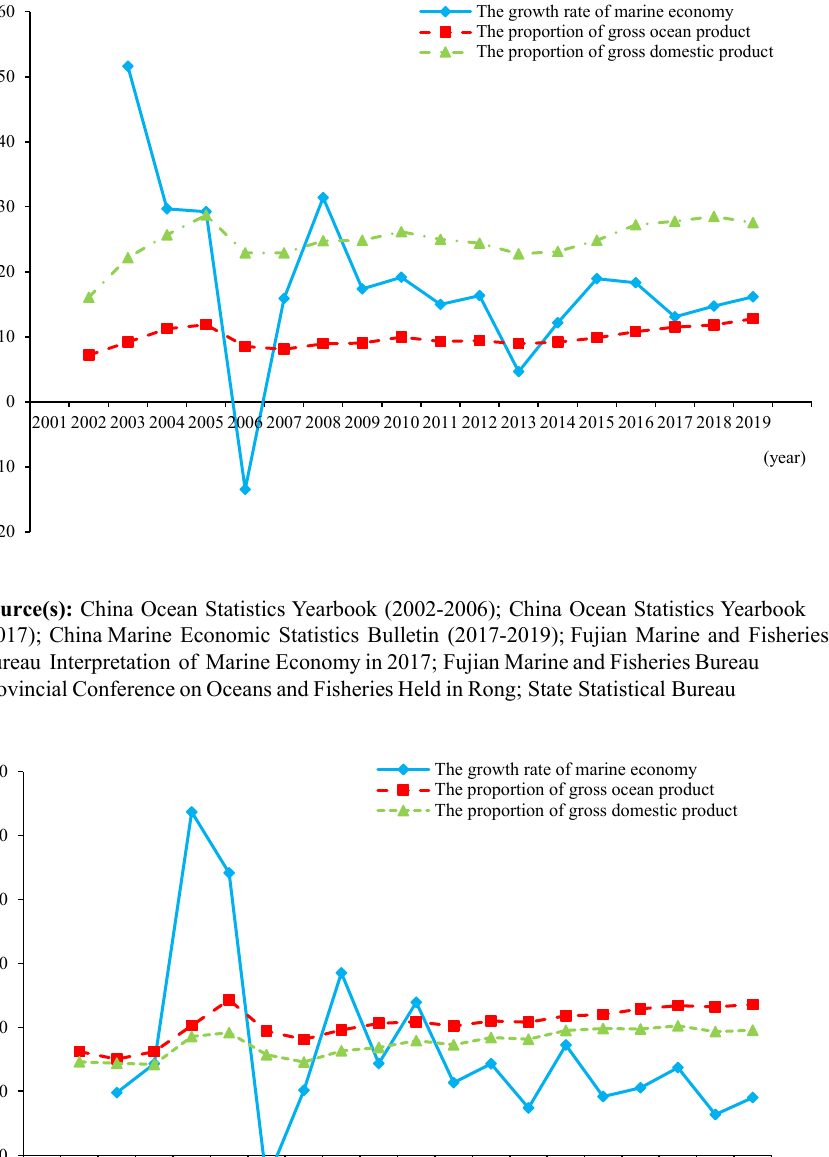
Figure 8. Development of